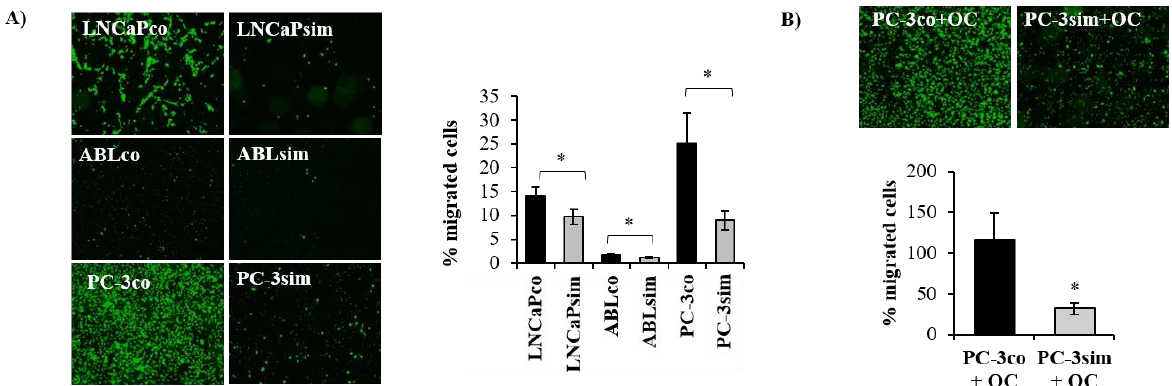
Figure 7. Long-term simvastatin treatment reduced the migration capacity of PCa cells per se and towards osteoclasts. ( A ) Cells were seeded into 24-well fluoroblok transwell inserts as described under material and methods in serum-starved culture medium and allowed to migrate through the membrane towards medium containing 10% fetal calf serum for 72 h. Following staining with calcein, representative images were taken with a JuLi live cell imager (4 × magnification). Fluorescence of migrated cells was quantified with a Cytation™ 5 Cell Imaging Multi-Mode Reader and expressed as percentage of migrated cells. ( B ) PC-3co and PC-3sim cells were seeded into 24-well plate Fluoroblok transwell inserts in serum-starved medium and allowed to migrate towards the lower chamber where differentiated osteoclasts (OC) were cultured over 8 days in the presence of PMA (50 ng/mL), RANKL (50 ng/mL), and M-CSF (25 ng/mL). Data are represented as mean ± SEM. (* p < 0.05).